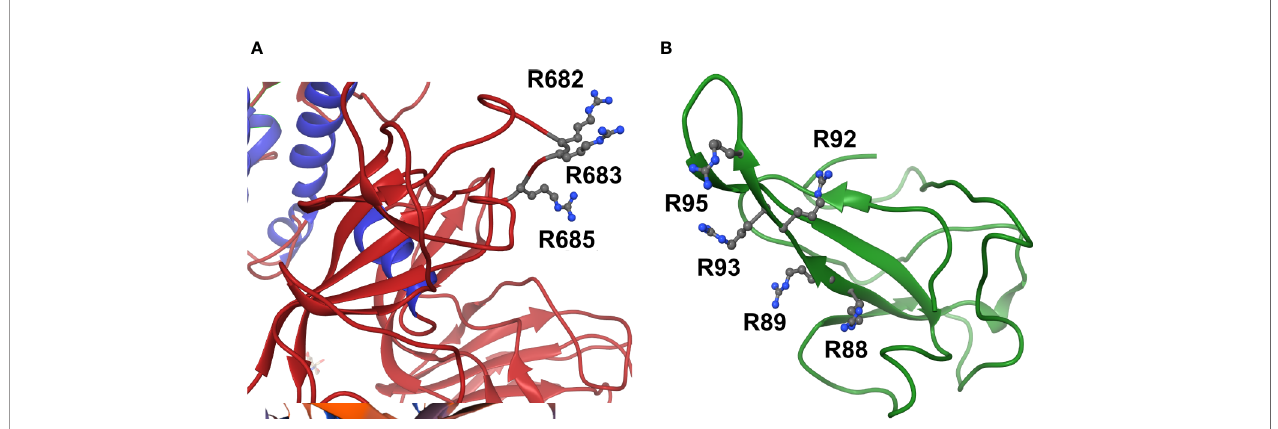
FIGURE 2 | Activation of functional arginine residues toward modi fi cation by methylglyoxal in the SARS-CoV-2 proteome. (A) Activated arginine residues triad of Spike protein, R 682 R 683 AR 685 . (B) Activated arginine residue pentad of nucleoprotein, R 88 R 89 ATR 92 R 93 IR 95 . Molecular graphics produced from Spike protein (pdb fi le 6VSB) (Wrapp et al., 2020) and nucleoprotein segment crystal structure (pdb fi le 6VYO; Chang et al., to be published) using Chimera 1.14 (Pettersen et